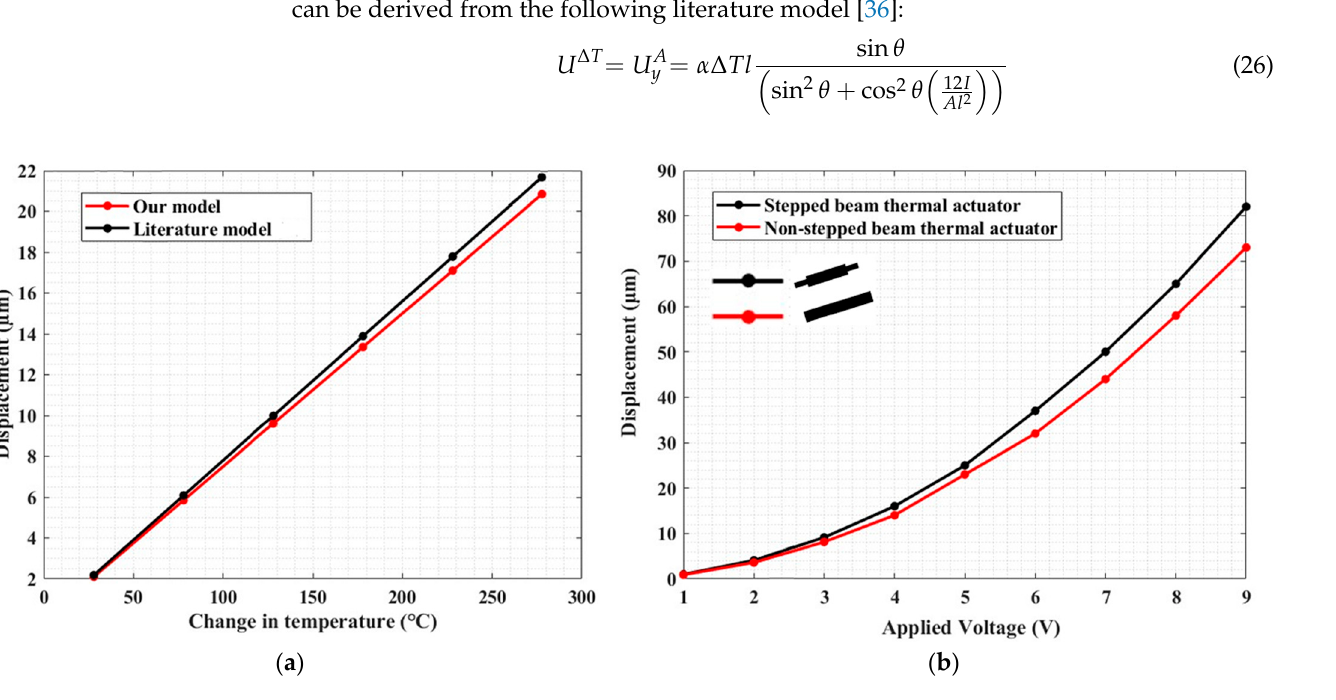
Figure 4. ( a ) Displacement vs. temperature change in one inclined thermal actuator beam with uniform cross-section modeled through a literature model [36] and our model at a tilt angle of 2°; ( b ) comparison between non-stepped beam thermal actuator and stepped beam thermal actuator in terms of displacement when the actuator is biased with 1–9 V.